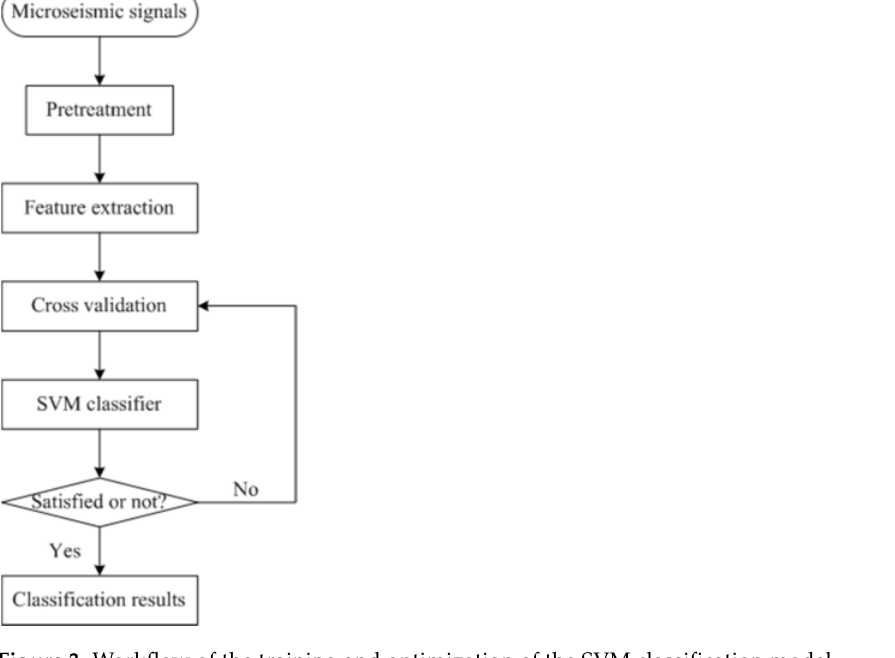
Figure 3. Workflow of the training and optimization of the SVM classification model.